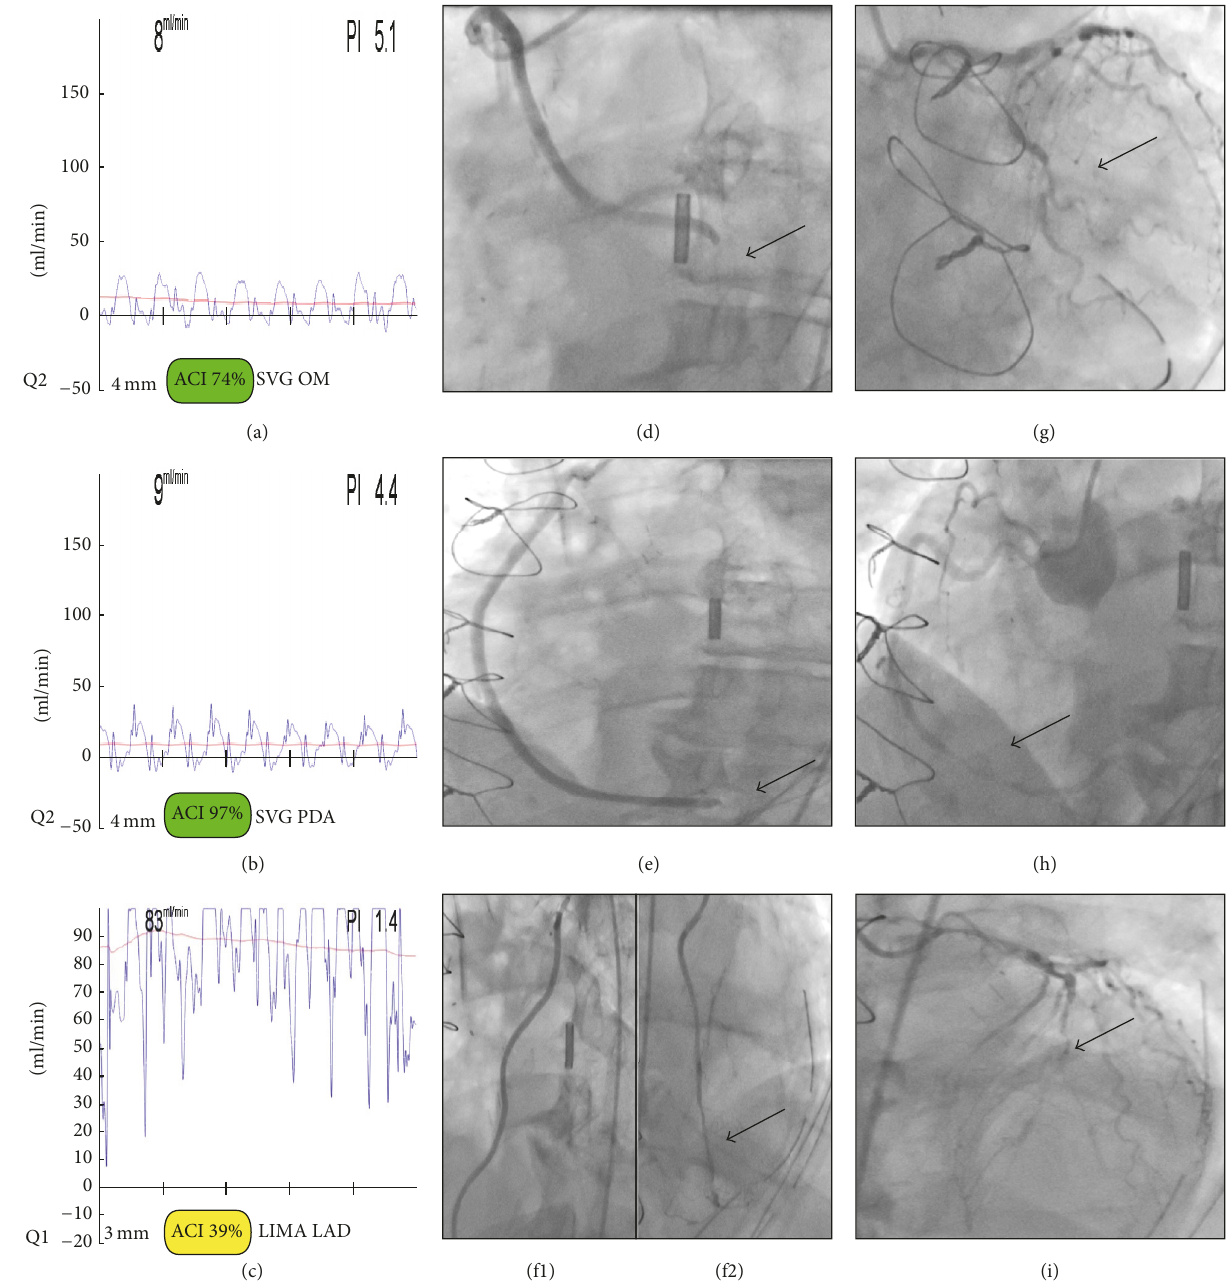
Figure 1: The VeriQ will display the Doppler spectrum at the default 5 seconds sweep rate as soon as a probe is connected, as shown in the figure. In Figures 1(a)–1(c) there is a flow-time curve of SVG to OM, SVG to PDA, and LIMA to LAD, respectively. After completion of all three grafts, there was good MGF in the arterial but not in the vein grafts. TTFM measurements with a mean arterial pressure of 80 mmHg were as follows: LIMA to LAD: MGF 83 ml/min and PI 1.4; LSV to OM: MGF 8 ml/min and PI 5.1; LSV to PDA: MGF 9ml/min and PI 4.4 (Figures 1(a)–1(c)). An urgent angiography confirmed the patency of all three grafts with wide spread evidence of spasm to native coronary arteries (Figures 1(d)–1(i)). The arrows refer to spasm.